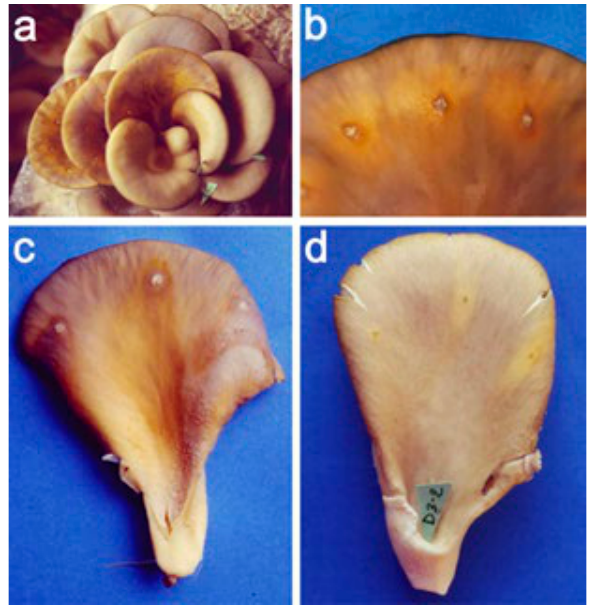
Figure 3. Pathogenicity assays on Pleurotus ostreatus whole sporocarps inoculated with bacterial masses. Sunken yel- low-orange lesions surrounded by yellow halos caused by strains USB1, USB22 and NCPPB2192 of Pseudomonas tolaasii (a and b), and yellow-orange lesions caused by strains USB6, USB20 and NCPPB1311 of P. ‘reactans’ (c) and strains USB33, USB34, USB36, USB55 and USB56 of fluorescent Pseudomonas spp. (d) on P. ostreatus sporocarps.